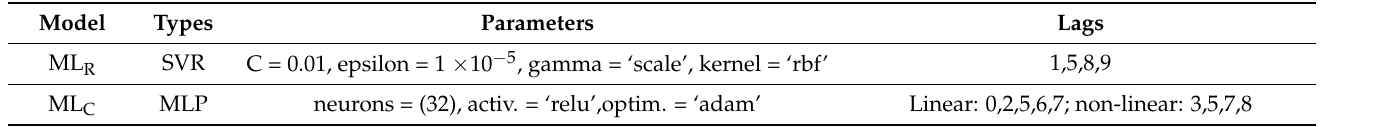
Table 1. Selected models by Genetic Algorithm